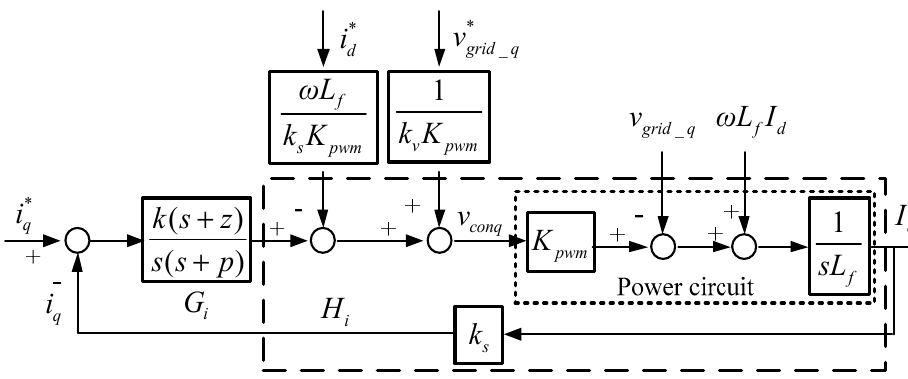
Figure 5. Control loop of q-axis current controller.